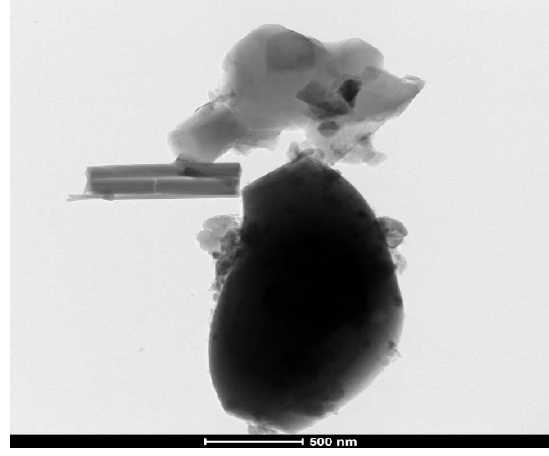
Figure 3. TEM images of CDC particles.